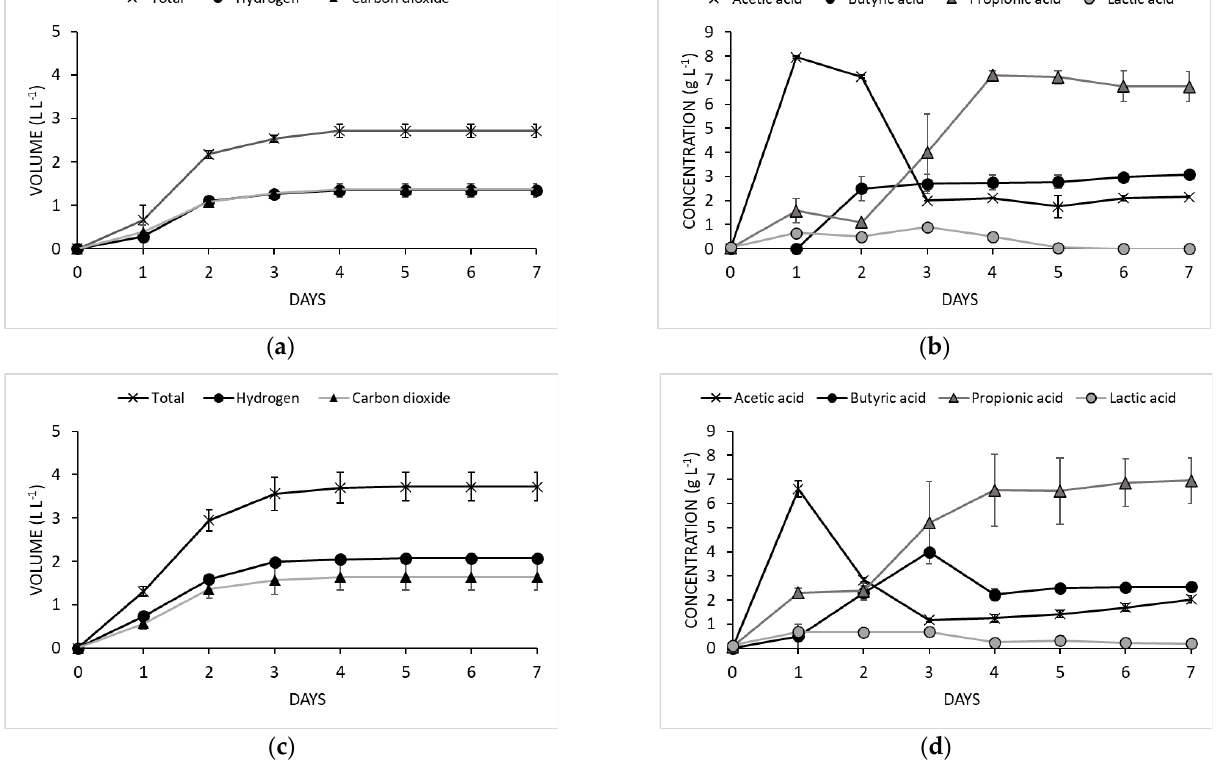
Figure 3. Experimental results of test CO 10% ( a , b ) and test CO 20% ( a , b ). ( a , c ) Cumulative total biogas, hydrogen, and carbon dioxide trends; ( b , d ) organic acids concentration (OAs) over time.